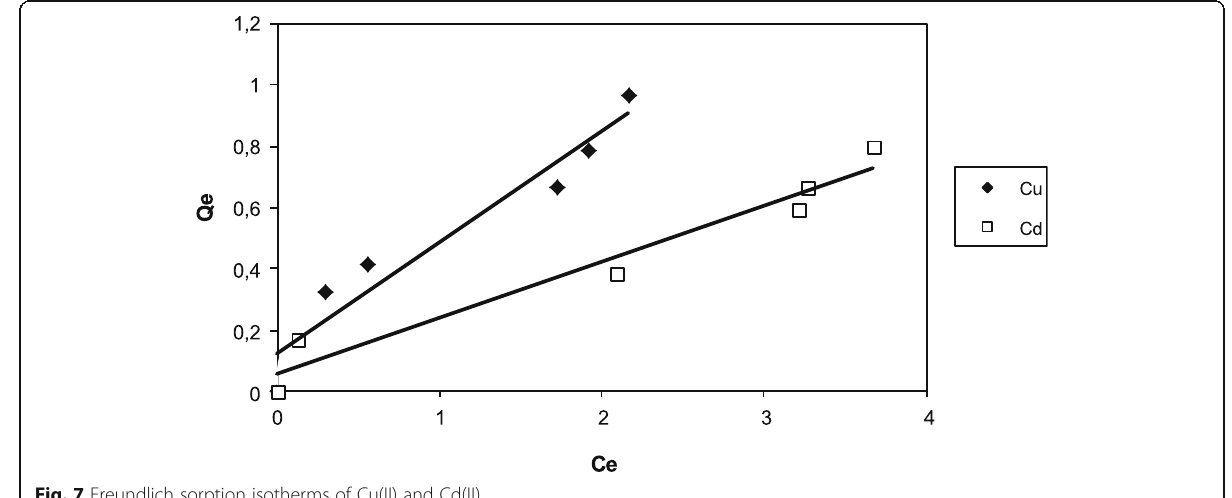
Fig. 7 Freundlich sorption isotherms of Cu(II) and